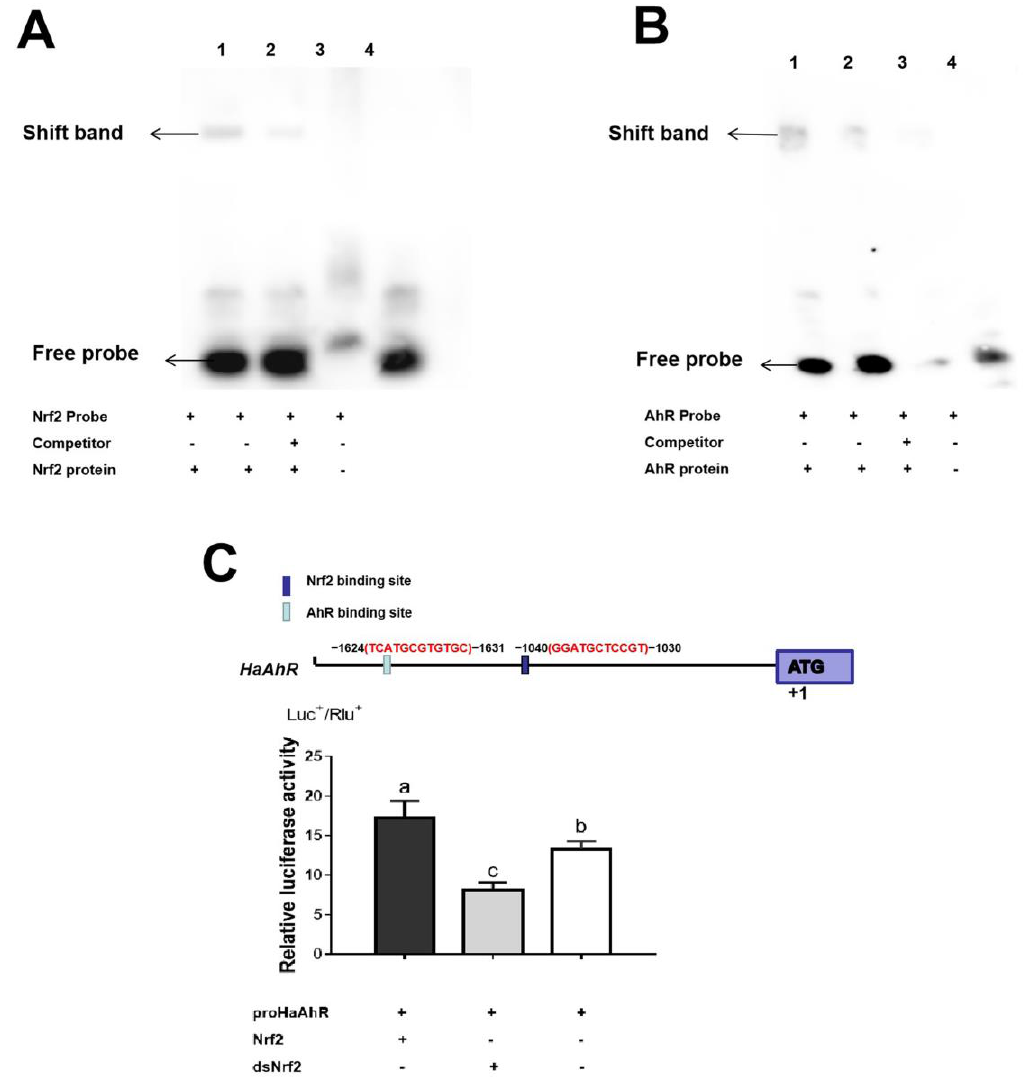
Figure 8. The crosstalk between HaNrf2 and HaAhR regulates the P450s, UGTs and GSTs genes in H. armigera . ( A ) EMSA method to verify the HaNrf2 binding sits in the promoter of HaAhR ; ( B ) EMSA method to verify the HaAhR binding sits in the promoter of HaAhR ; ( C ) overexpressed HaNrf2 and HaAhR effects on the promoter activity of HaAhR . Element position “+1” is defined relative to the start codon ATG. Different letters on error bars show significant differences ( p < 0.05).